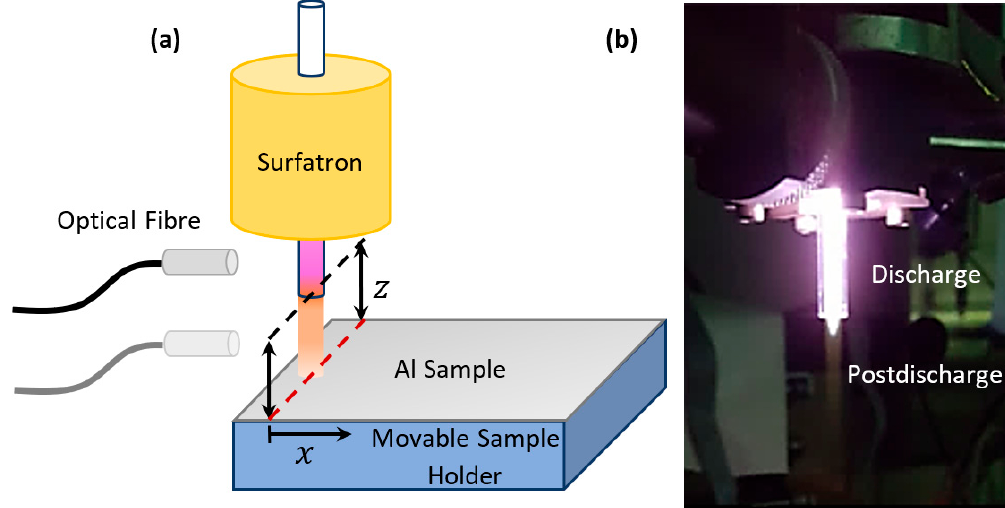
Figure 1. Experiment setup ( a ) and detail of an Ar-N 2 discharge and ( b ) postdischarge.